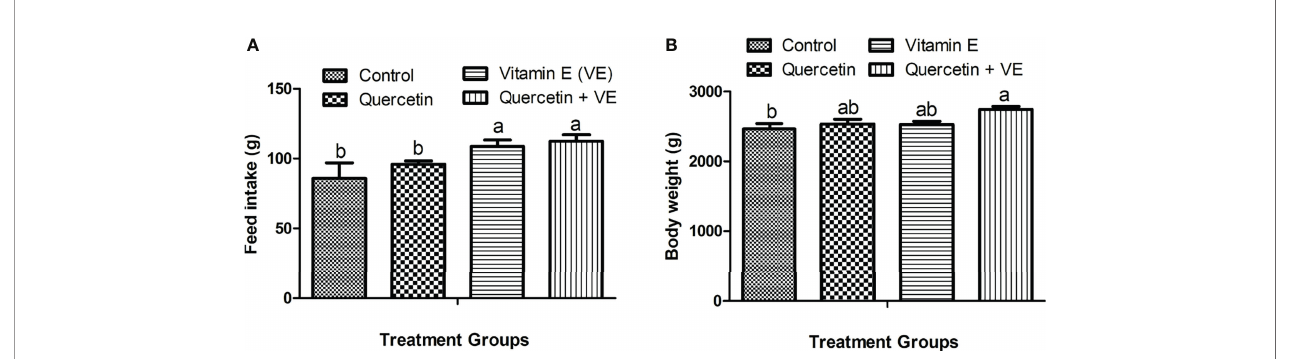
FIGURE 1 | Effects of quercetin (Q), vitamin E (VE), and Q + VE on feed intake and body weight of aged laying hens fed 14 weeks. Bars without the same letter differed signi fi cantly (P < 0.05). (A) Feed intake; (B) body weight.